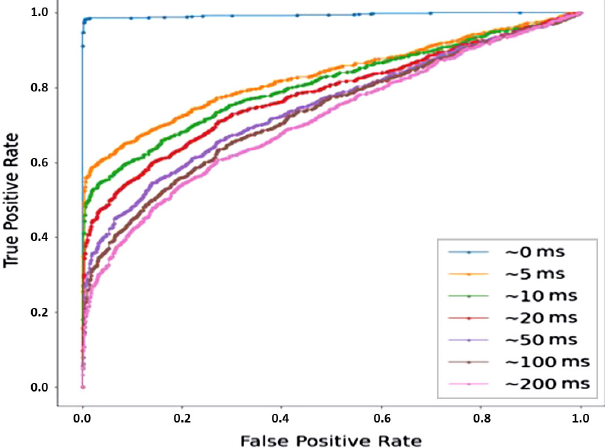
FIG. 12. ROC curves of classifying samples taken at different times before the SRF faults against normal samples (from [71], Fig.